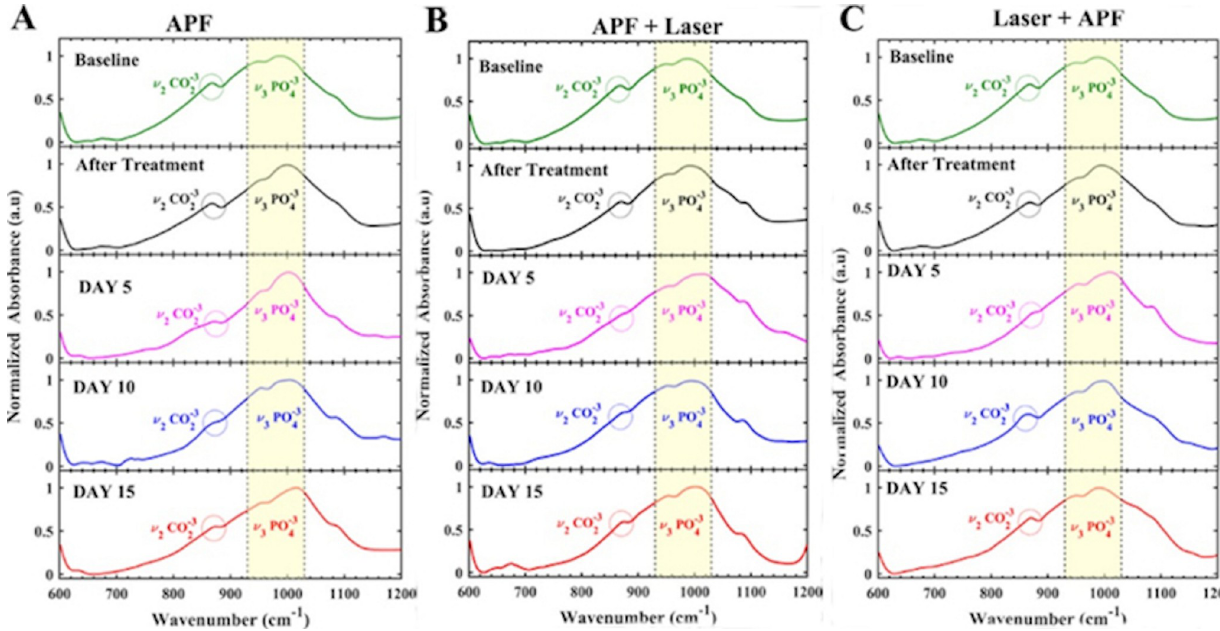
Fig 5. Representative spectra of each group over time, min-max normalized. A) APF Group; B) APF+Nd:YAG Laser; C) Nd:YAG Laser+APF.